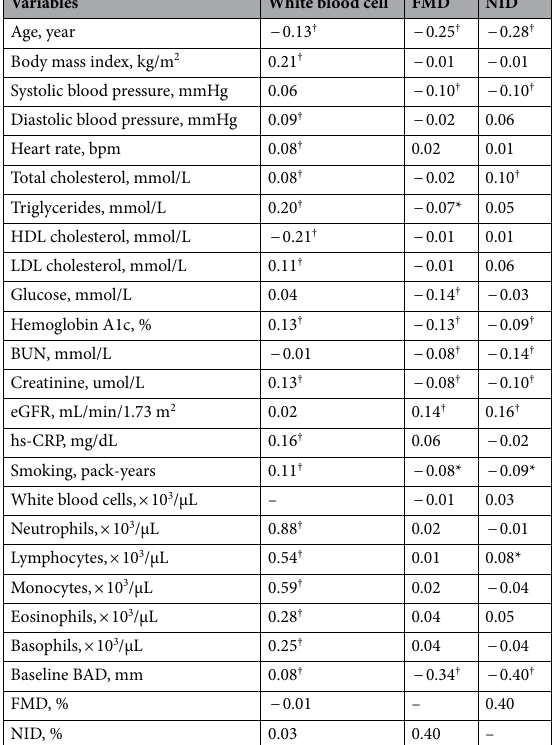
Table 2. Univariate analysis of relationships among white blood cell, FMD, NID and variables. FMD flow-mediated vasodilation, NID nitroglycerine-induced vasodilation, HDL high-density lipoprotein, LDL low-density lipoprotein, BUN blood urea nitrogen, eGFR estimated-glomerular filtration rate, hs-CRP high- sensitive C-reactive protein, BAD brachial artery diameter. *P < 0.05, † P <